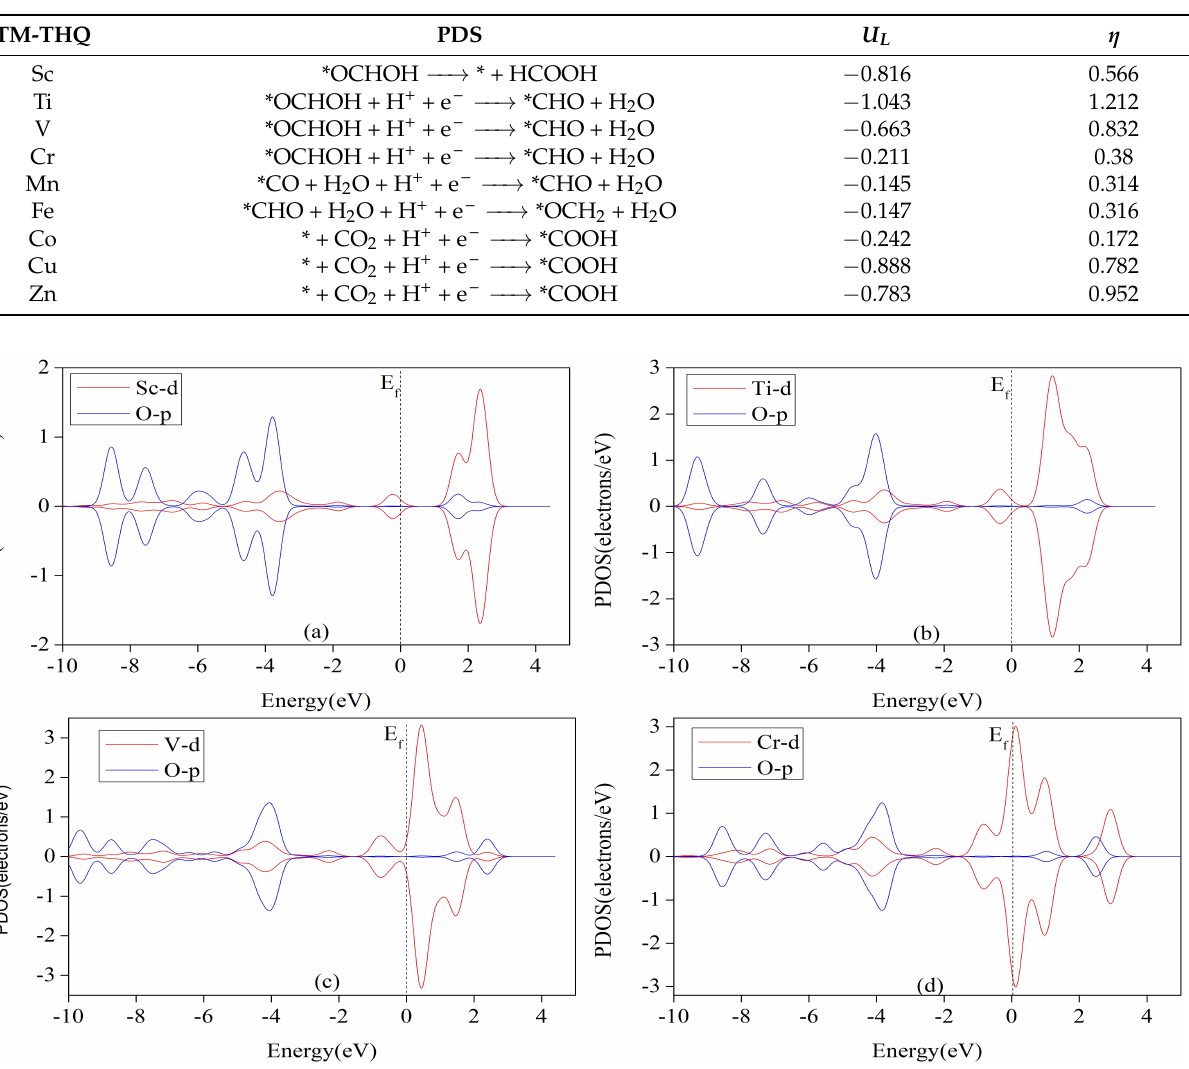
Table 3. TM-HTQ is used as a rate-determining step for electrocatalytic CO 2 reduction, limiting potential ( U L /V), overpotential ( η /V).